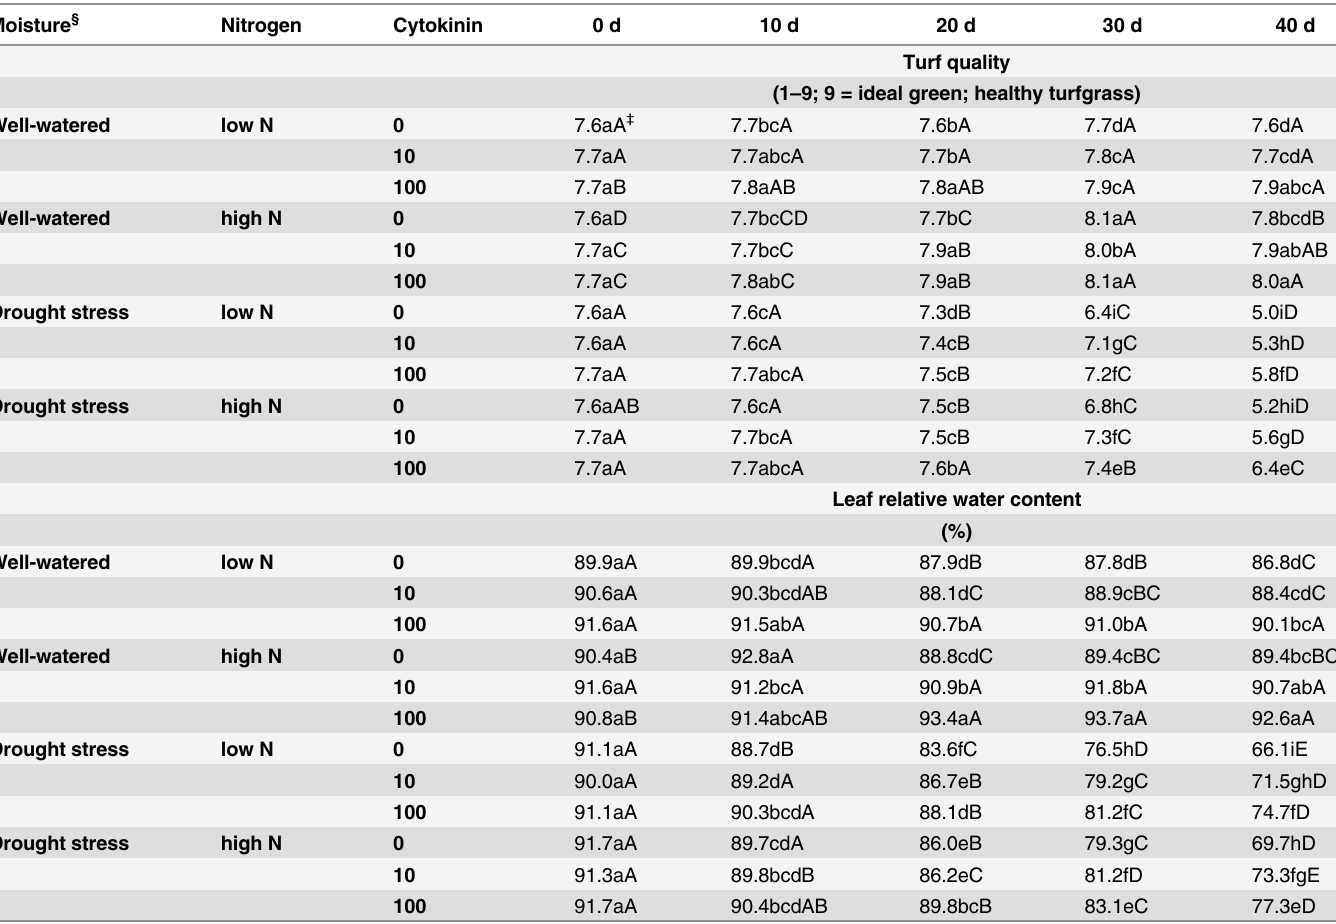
Table 1. Cytokinin and nitrogen impact on turf quality and leaf relative water content of creeping bentgrass subjected to two moisture regimes. Moisture §